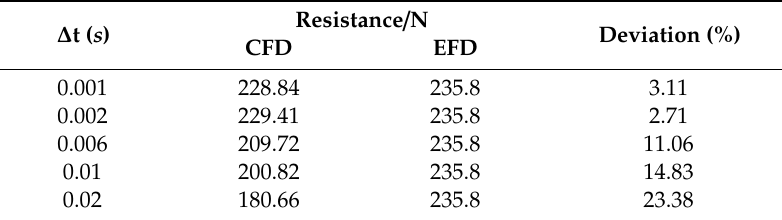
Table 7. Numerical results of different ∆ t (time steps).